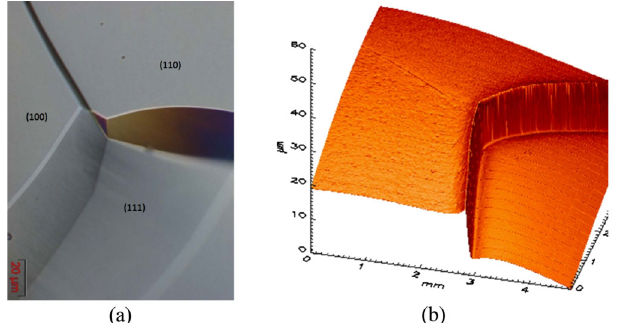
FIG. 16. Light microscope image of the grain boundary triple junction of LG Nb after 100 (cid:4) m BCP on the previously me- chanically polished sample (a). Orientation type is shown on grains. Atom force microscope image of the same area (b). Steps on grain boundaries are within 1 : 5 – 15 (cid:4) m for this orientation